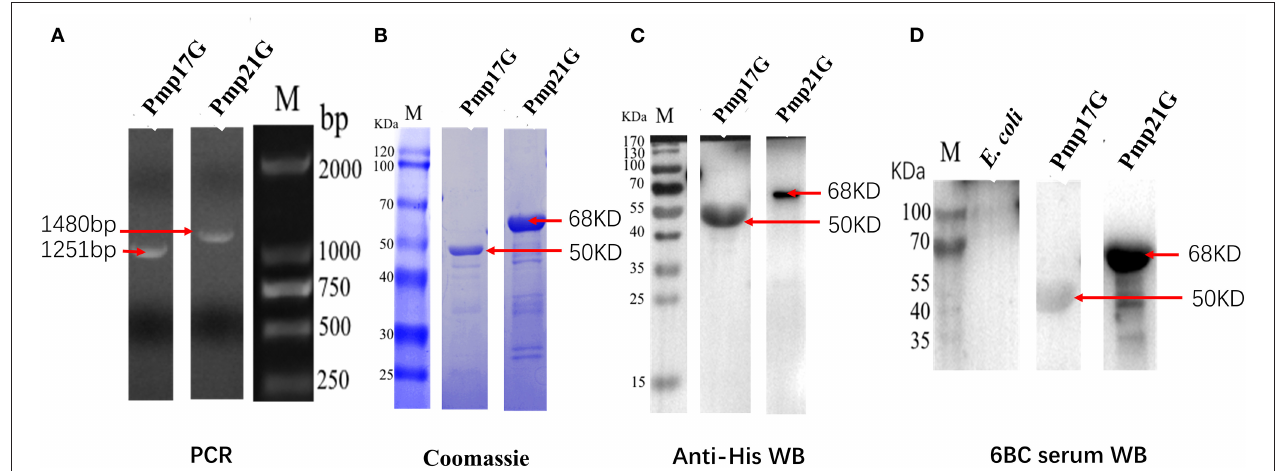
FIGURE 1 | Expression and identification of Pmp17G and Pmp21G. (A) The pmp17G and pmp21G genes fragments were amplified to be 1,251 and 1,480 bp, respectively, by PCR. (B) Recombinant Pmp17G and Pmp21G were 50 and 68 kDa, respectively, using Coomassie blue staining. (C) Two recombinant proteins were reacted to anti-His antibody and positive Chlamydia psittaci by Western blot. (D) No cross reaction to Escherichia coli Rossetta (DE3) cells was observed.